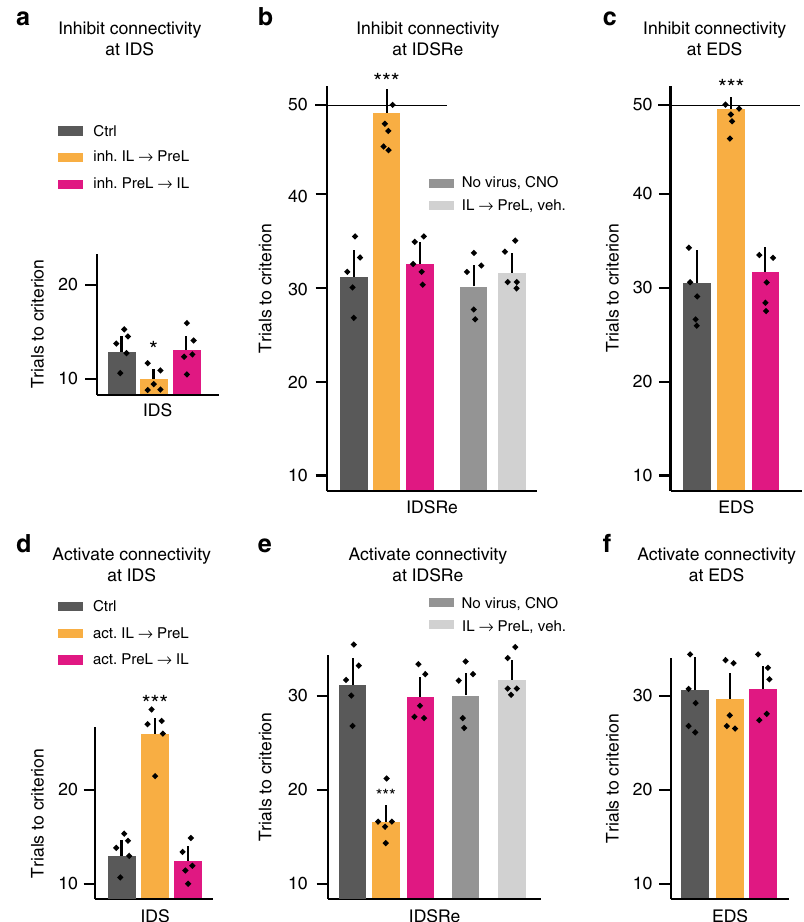
Fig. 3 IL → PreL neurons are required for IL driven shifting in IEST. a – c Silencing IL → PreL, but not PreL → IL projection neurons during IDS ( a ; n = 5 each; F (2, 12) = 6.64, * P = 0.011), IDSRe ( b ; n = 5 each; F (4, 20) = 17.08, *** P ), or EDS ( c ; n = 5 each; F (2, 12) = 17.89, *** P ) learning reproduces the effect of IL silencing during the same IEST subtasks. These experiments involved inhibitory DREADDS into IL or PreL projection neurons, and delivery of CNO or vehicle 20 min before learning; CNO ligand alone or virus alone had no impact on IDSRe learning ( b ). d, e Activating IL → PreL, but not PreL → IL projection neurons during IDS ( d ; n = 5 each; F (2, 12) = 25.39, *** P ) or IDSRe ( e ; n = 5 each; F (4, 20) = 20.01, *** P ) reproduces the effect of silencing PreL during the same subtasks. f Activating IL → PreL projection neurons during EDS has no detectable impact on learning performance ( n = 5 each; F (2, 12) = 1.08, P = 0.371, ns ). These experiments involved excitatory DREADDS into IL or PreL projection neurons, and delivery of CNO or vehicle 20 min before learning. CNO ligand alone or virus alone had no impact on IDSRe learning ( e ). Error bars: SEM; one-way ANOVA followed by Dunnet ’ s post hoc; P < 0.05 ( * ),